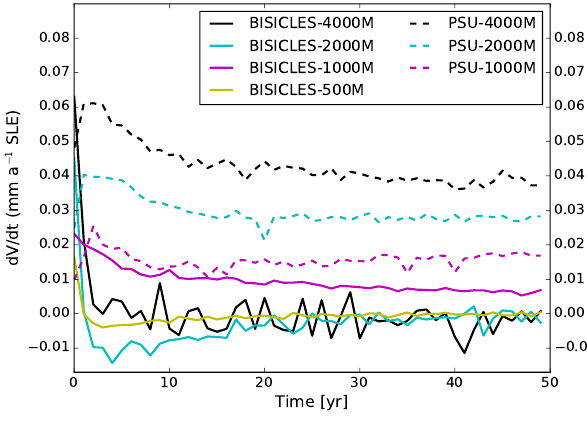
(cid:16) ∂V (cid:17) Figure 3. Volume change spin-up plot for BISICLES (solid ∂t lines) and PSU3D (dashed lines) at different horizontal